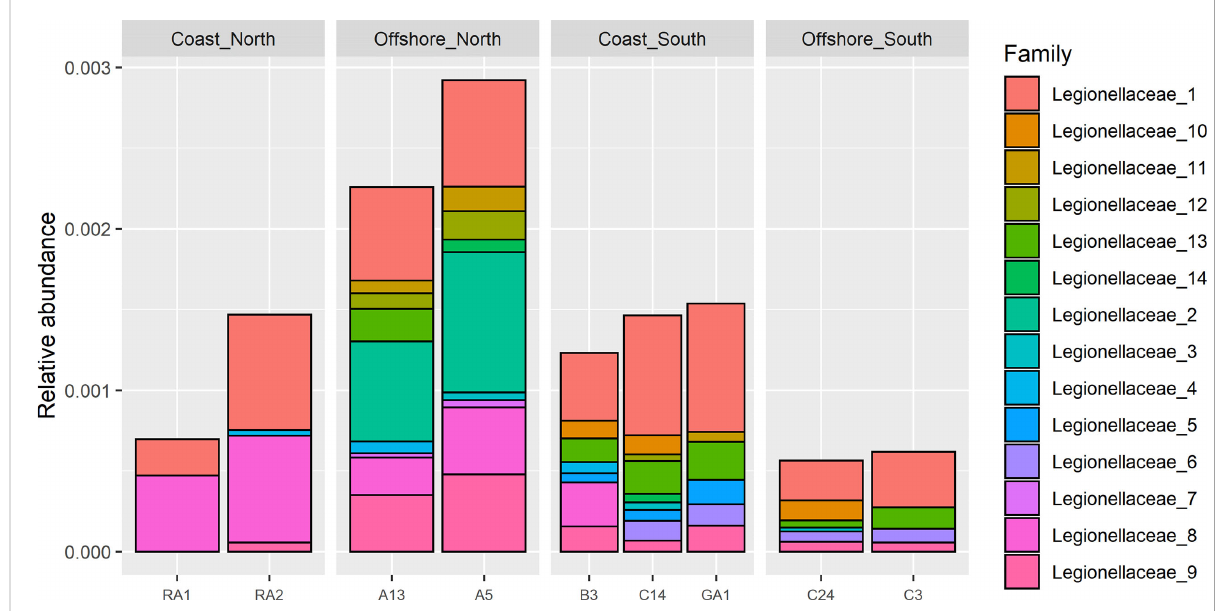
FIGURE 4 Filtered Illumina Legionellaceae ASVs, detected in more than one sample (ASVs used in